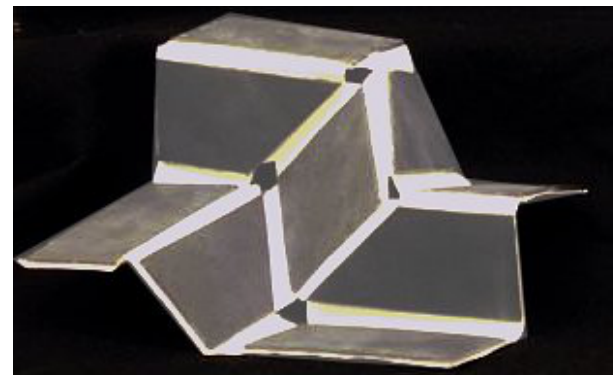
Fig. 3. A rigid-foldable version of the square twist origami con- Figure 3. A common double slit kirigami representation and its corresponding PRBM both shown placed in the crease of a folded structed from polypropylene sheet and paper. The polypropylene sheet of paper. shows that it behaves rigidly, where bending is only allowed at the folds.